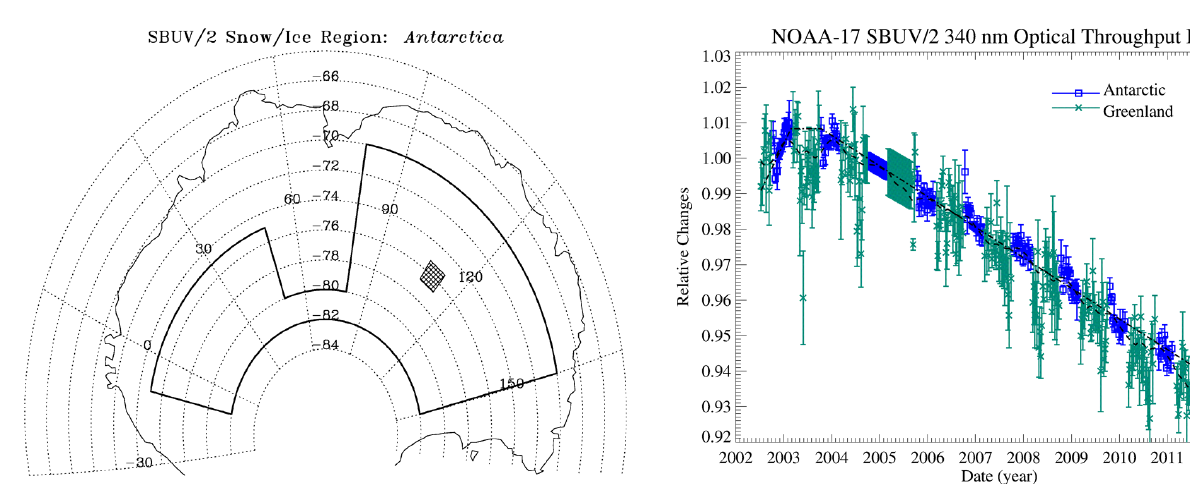
Fig. 4. NOAA-17 SBUV/2 snow/ice albedo data at 340nm for characterization of instrument sensitivity time dependence. Squares = Antarctic data. Crosses = Greenland data. All measure- ments are normalized to October